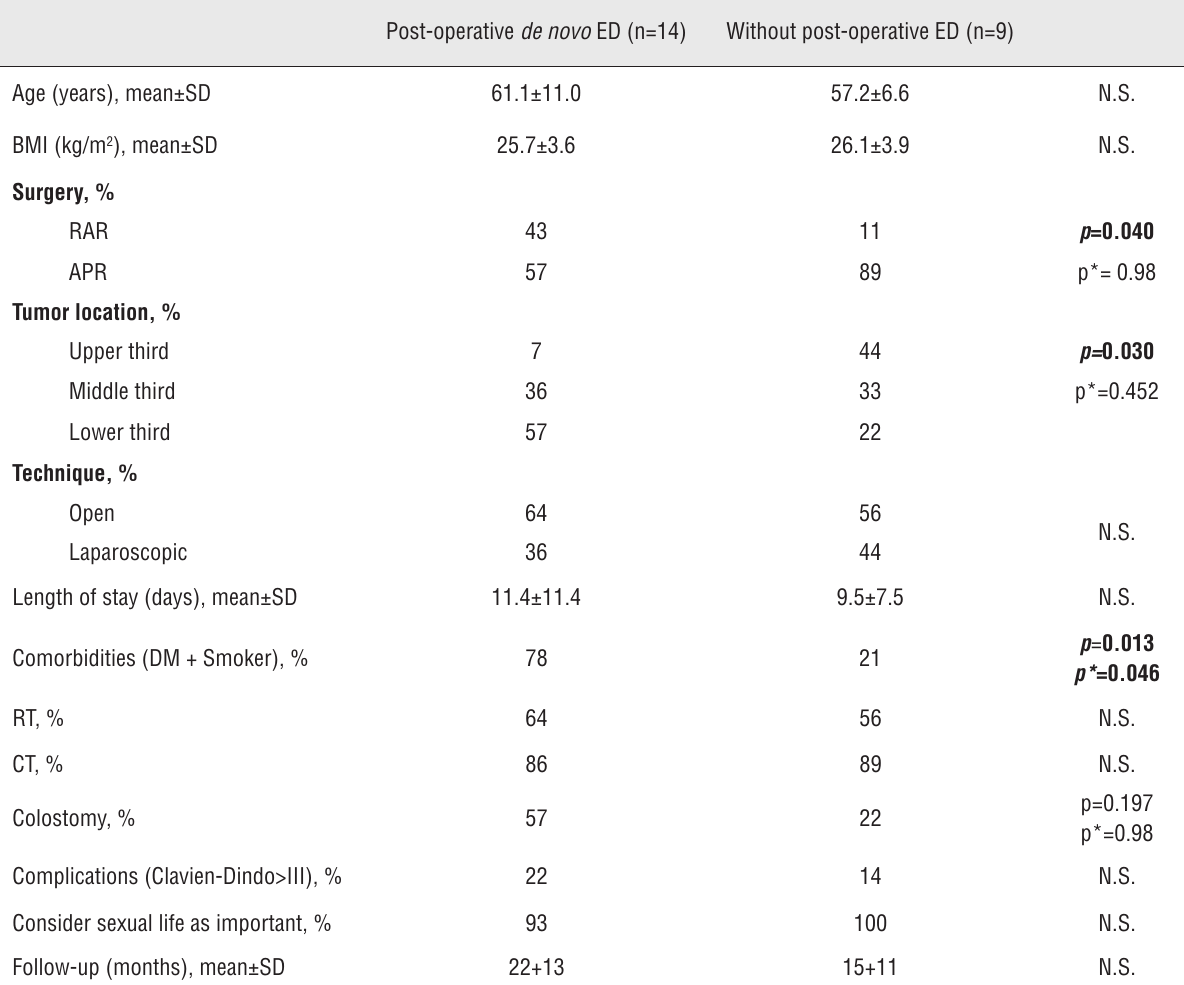
Table 4 – univariate and multivariate* analysis including only patients without pre-operative erectile dysfunction(ED) – comparison of characteristics of patients with de novo post-operative ED and patients without